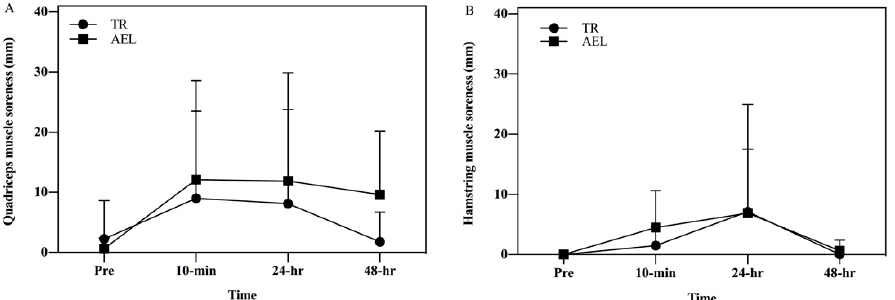
Figure 3. Comparisons of quadriceps ( A ) and hamstring ( B ) muscle soreness between accentuated eccentric loading exercise (AEL) and traditional resistance loading exercise (TR) group.